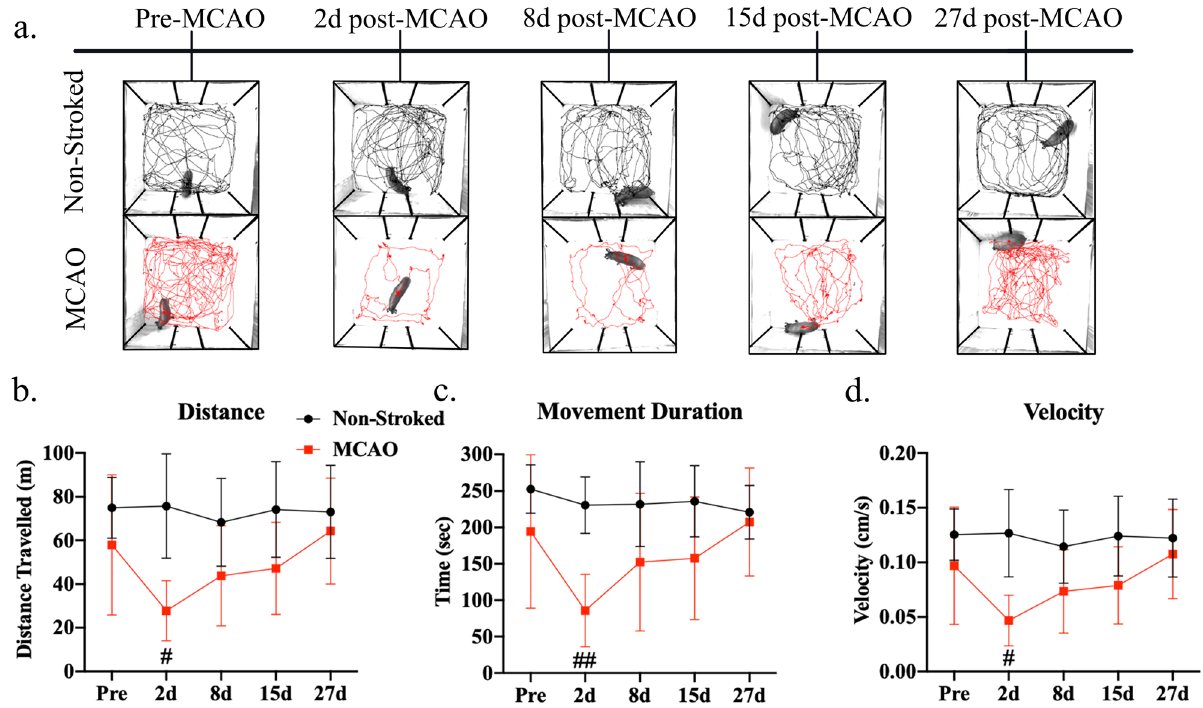
Figure 4. Stroke decreased acute voluntary movement in open field behavioral test. Representative 10-min movement tracings shown for non-stroked (black) and MCAO (red) pigs across all time points ( a ). At 2d post-MCAO, MCAO pigs had decreased distance traveled ( b ), movement duration ( c ), and average velocity ( d ) compared to non-stroked pigs. No significant differences were observed at 8d, 15d, and 27d post-MCAO in both groups ( p > 0.05). # and ## indicated statistically different between